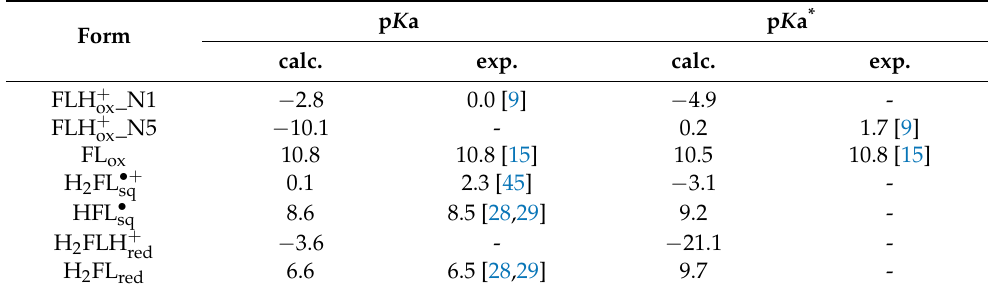
Table 2. The p K a and p K a * of the flavins. Form